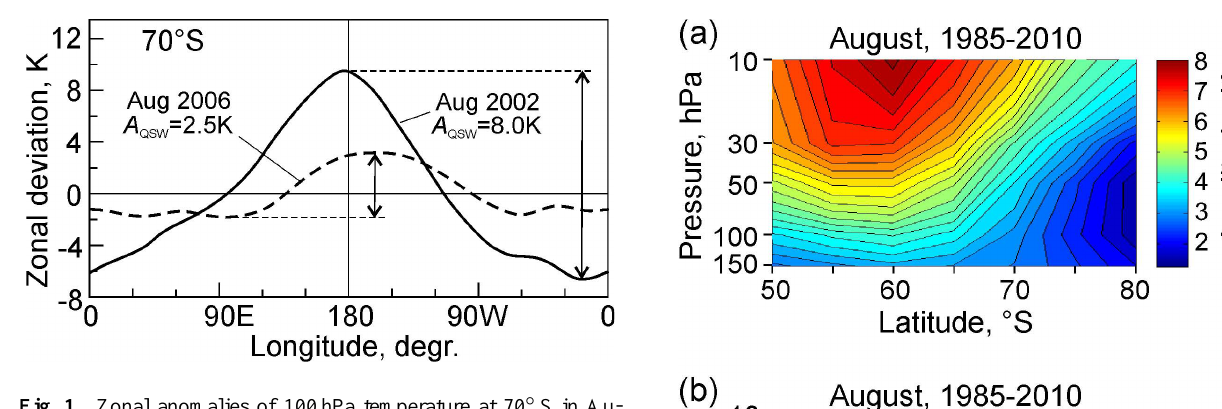
Fig. 1. Zonal anomalies of 100hPa temperature at 70 ◦ S in Au- gust 2002 (solid curve) and August 2006 (dashed curve) as an illus- tration of weak and strong vortex conditions, respectively.